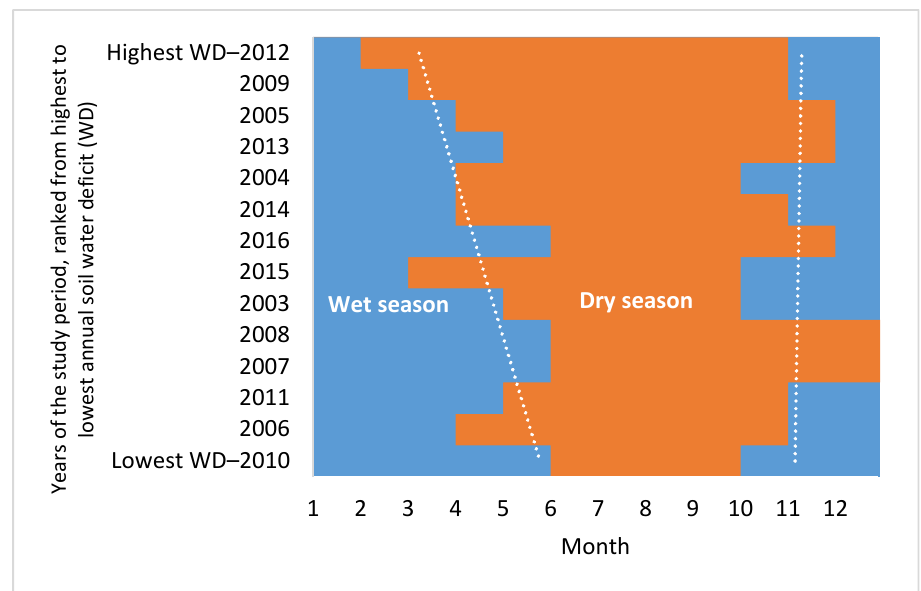
Figure 4. Extent of the dry and wet seasons (respectively, months with a soil water deficit and a superavit) during the study period, with years being ranked from the highest (top) to the lowest (bottom) annual soil water deficit (WD) for Smax = 100 mm.